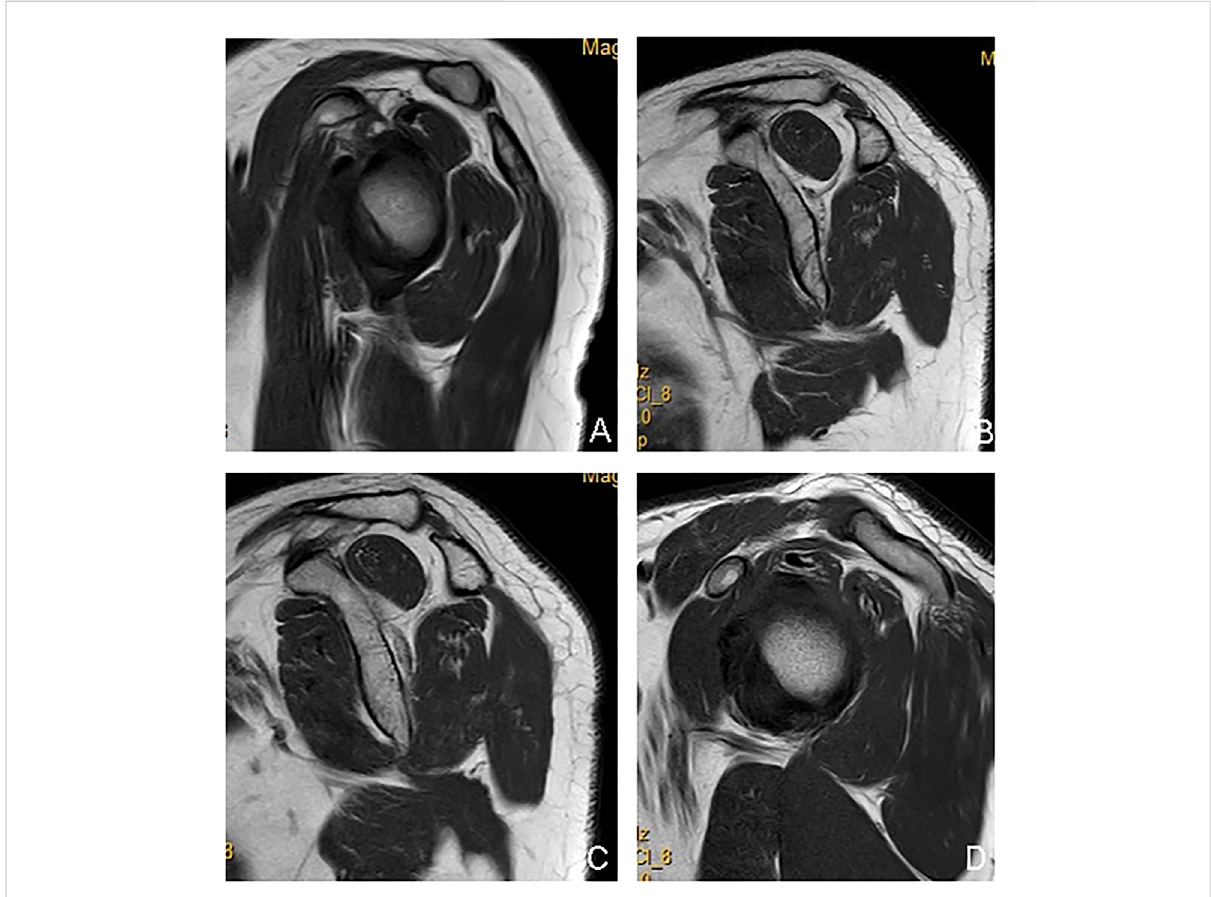
FIGURE 5 Goutallier grading display of rotator cuff Y-view (0 – 4 points), to evaluate the degree of abdominal atrophy and intramuscular fat deposition of the supraspinatus and infraspinatus muscles. (A) The shape of thesupraspinatus and infraspinatusmuscles is normal, and there isno fat signal inside, Goutallier = 0 points; (B) The shape of the supraspinatus and infraspinatus muscles is normal, and there is a fat streak signal in the supraspinatus muscle, Goutallier = 1 point; there are multiple fat signals in the infraspinatus muscle, but the muscle signal range is greater than the fat signal range, Goutallier = 2 points; (C) The supraspinatus muscle was slightly atrophied, and there were fl aky fat signals inside, but the muscle signal range was greater than the fat signal range, Goutallier = 2 points; the infraspinatus muscle was slightly reduced in size, and multiple fat signals